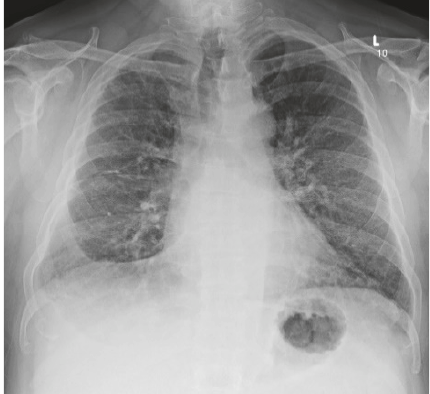
Figure 4: Anteroposterior chest X-ray taken at the hospital admis- sion during acute exacerbation of DIP. Right pleural effusion and bilateral lung interstitial opacities.